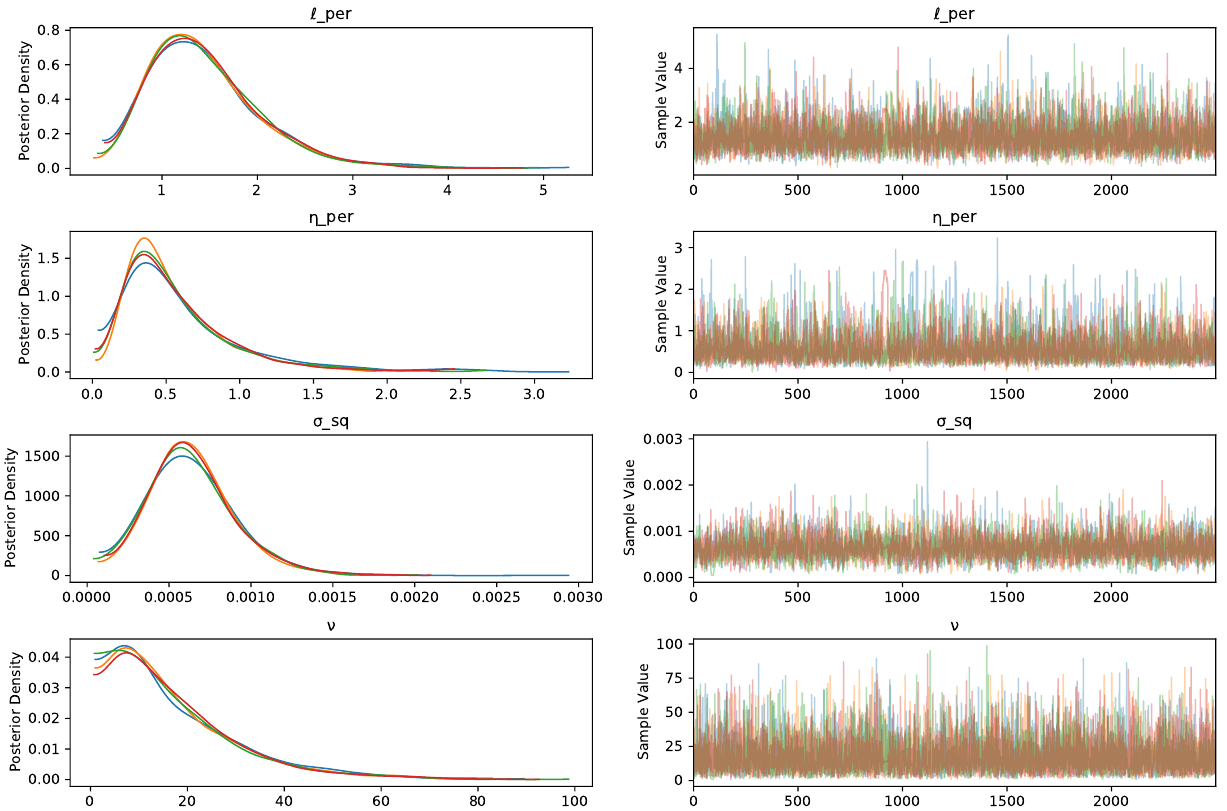
Figure 10. Posterior distributions and trace plots for the North Dakota VIIRS-NDIC scale factor model. Well mixing and convergence are achieved.